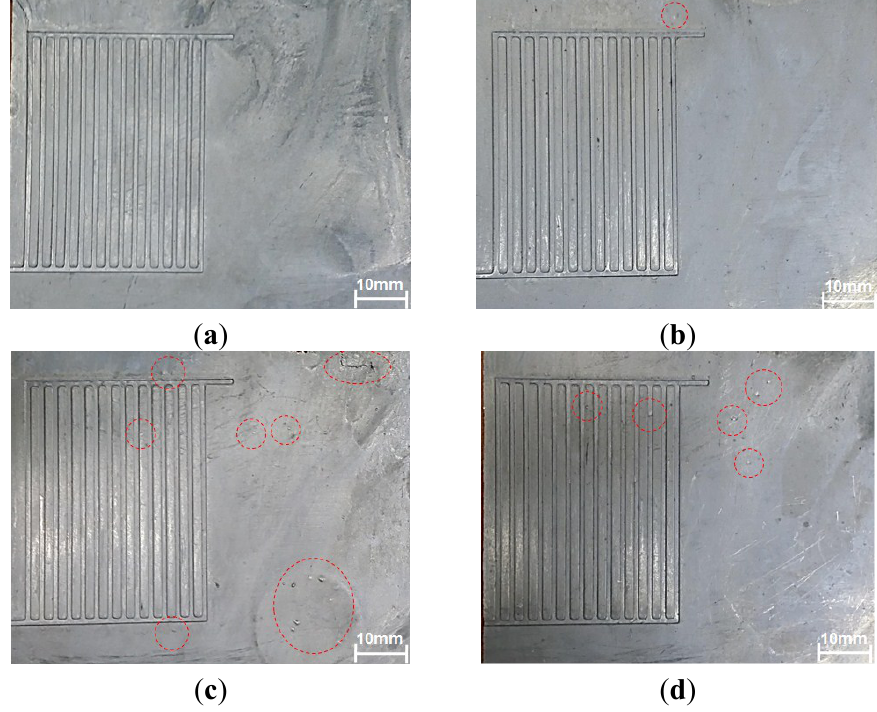
Figure 9. Appearance of samples after blister test (490 °C, five hours): ( a ) Condition 3 ( T = 710 °C, V 2 = 3.0 m/s); ( b ) Condition 6 ( T = 730 °C, V 2 = 3.0 m/s); ( c ) Condition 1 ( T = 710 °C, V 2 = 2.5 m/s) and ( d ) Condition 4 ( T = 730 °C, V 2 = 2.5 m/s). The red areas represent blister defects.